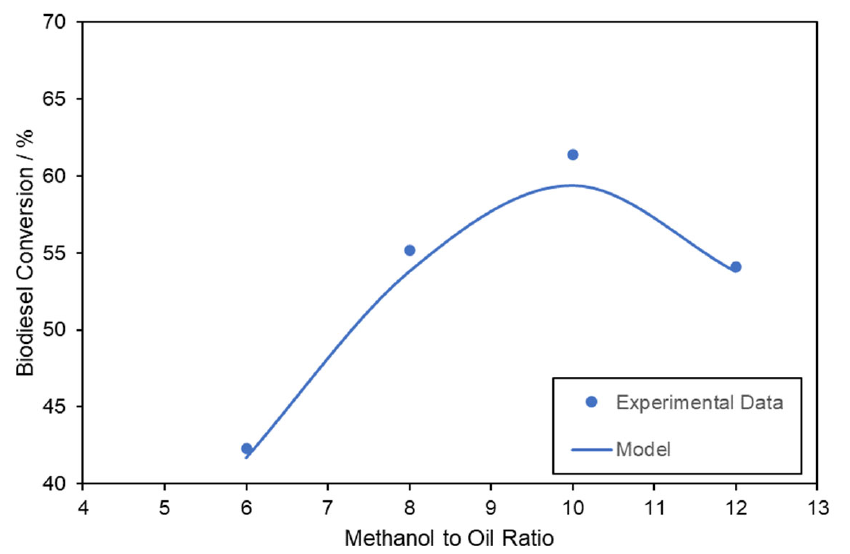
Figure 7. Methanol-to-oil ratio effect at a constant temperature of 533 K and reaction time of 20 min on the conversion to biodiesel, using oil derived from Schizochytrium limacinum . Experimental data were taken from [36].